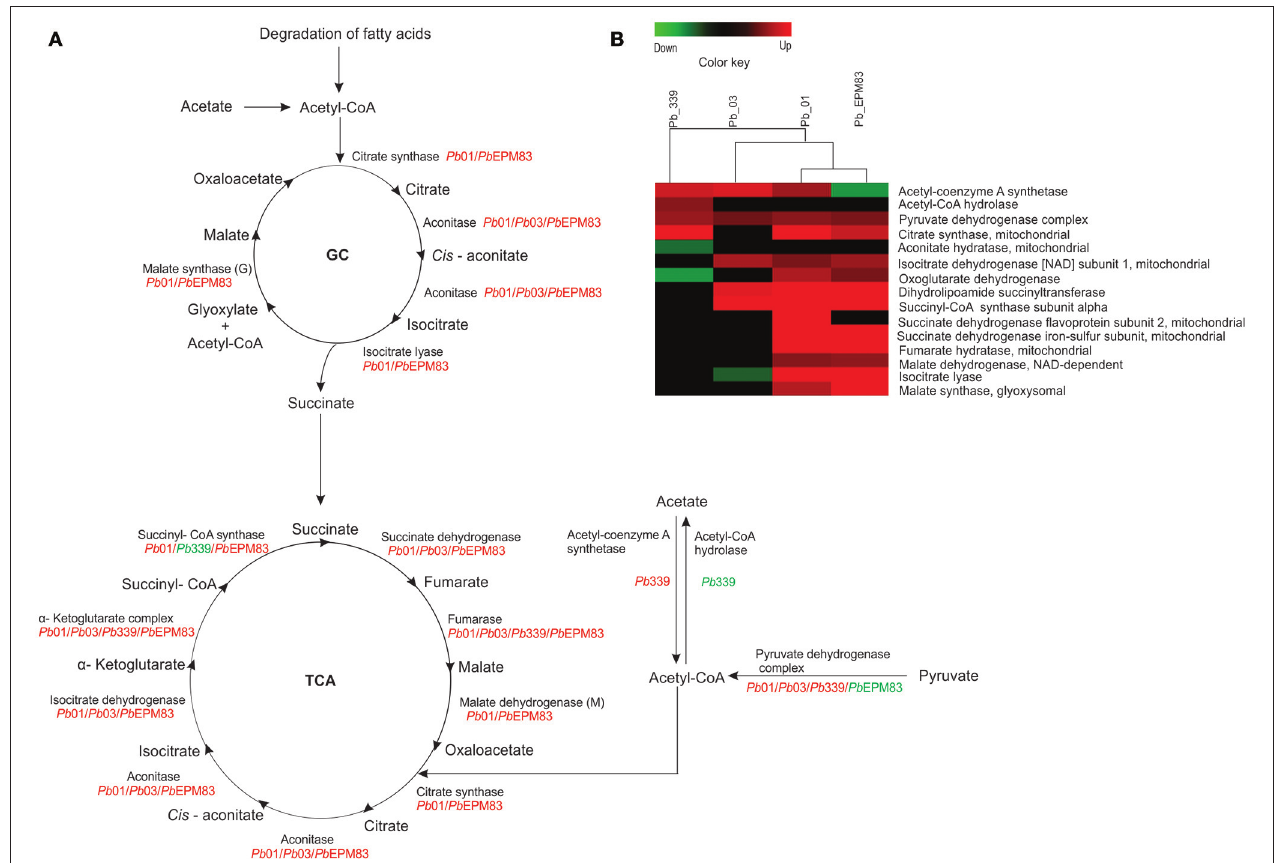
FIGURE 5 | Comparison of protein profiles related to TCA and glyoxylate cycle in P. lutzii and isolates of P. brasiliensis . Dataset comparisons were carried out as cited in Figure 2 legend. (A) Representative diagram of the TCA cycle and glyoxylate cycle depicting down-regulated (green) and up-regulated (red) proteins in the isolates. (B) Changes in expression levels upon yeast cells incubated with acetate in Pb 01, Pb 03, Pb 339, and Pb EPM83 are represented in a heat map format. Black indicates that no significant difference was